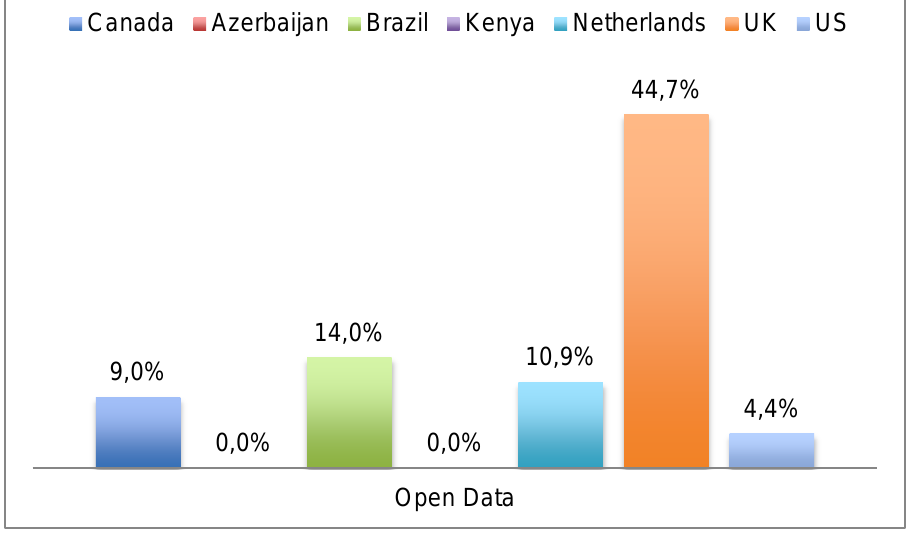
Figure 6: Salience of the code “Open Data” by country Action